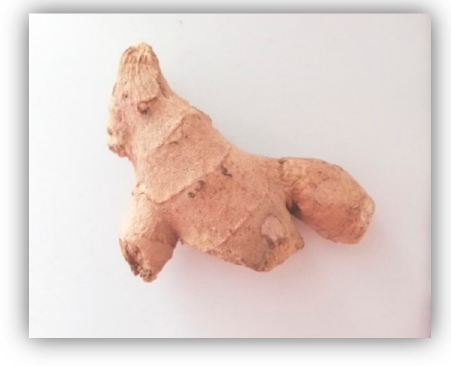
Figure 5. Raw ginger root.